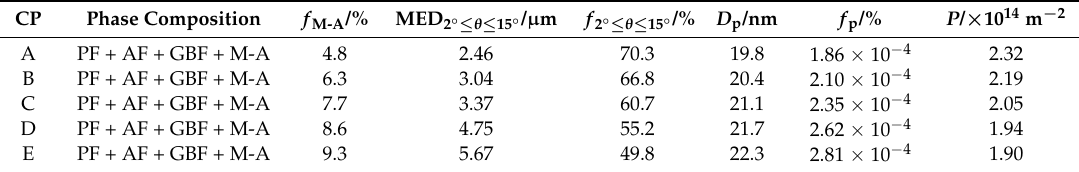
Table 2. Microstructural observation and quantification results for different CP samples.